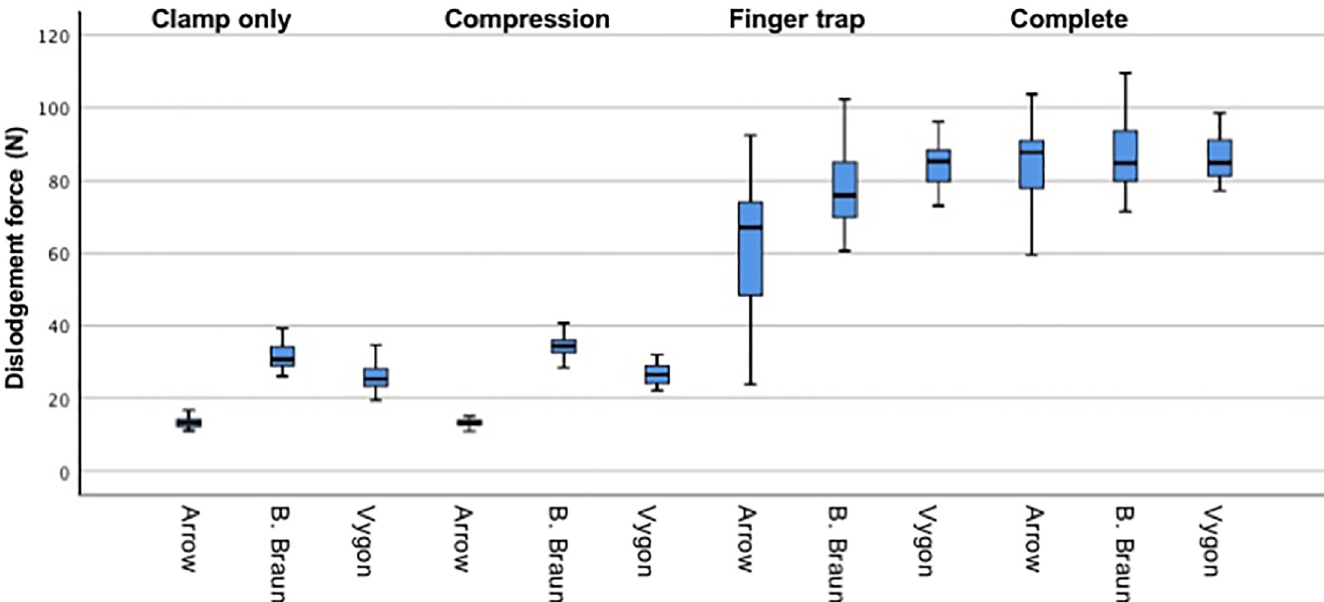
Fig 5. Dislodgement forces. Dislodgement forces measured in Newton (N). The boxes represent median, 25% and 75% quantile. The whiskers represent 1.5 x interquartile range. 300 test runs were performed in total, 25 test runs were performed in each experimental group.